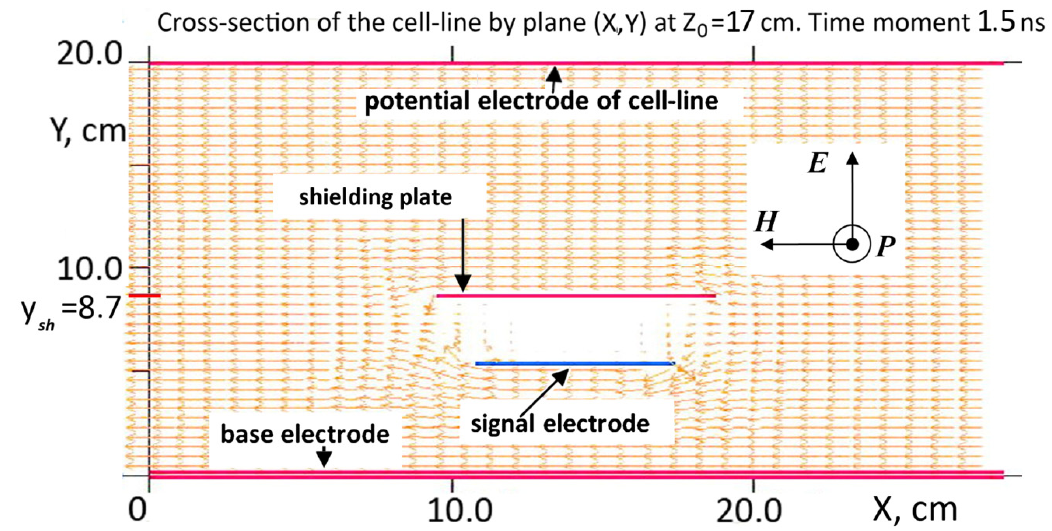
Figure 5. Distribution of the magnetic field (yellow arrows) in the ( X , Y ) plane at z = 17 cm and at time 1.5 ns.